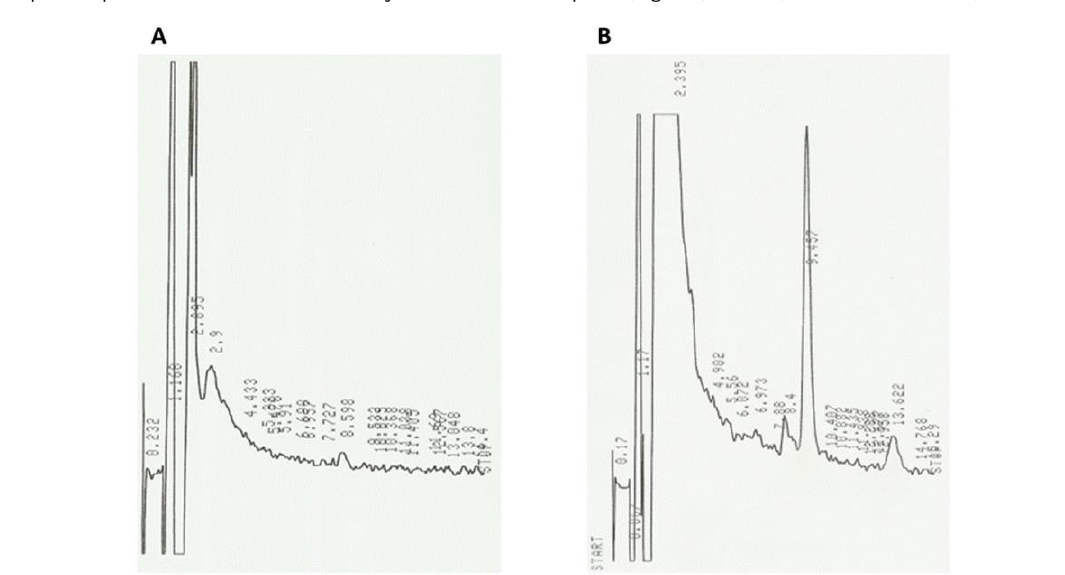
Figure 4: L -DOPA-treatment: (A) dopamine production in SH- SY5Y cells, after 30 minutes incubation eluted at 13.62 minutes. The tall spike at 9.45 minutes was the internal control DHBA. As a comparison, no dopamine was detected in cells not treated with L -DOPA (B). 3.4 Benserazide Inhibition Benserazide inhibits dopamine production by inhibiting the action of AADC enzyme. This is observed by the downward logarithmic curve generated from collective data in Fig. 6. This graph was generated from various amounts of benserazide and measuring residual dopamine synthesis at each inhibitor concentration. Logarithmic inhibition curves will slope towards without ever reaching the x-axis. The value at which benserazide exert 50% inhibition against L -DOPA is 0.22 mg/ml, making it a very potent inhibitor (data not